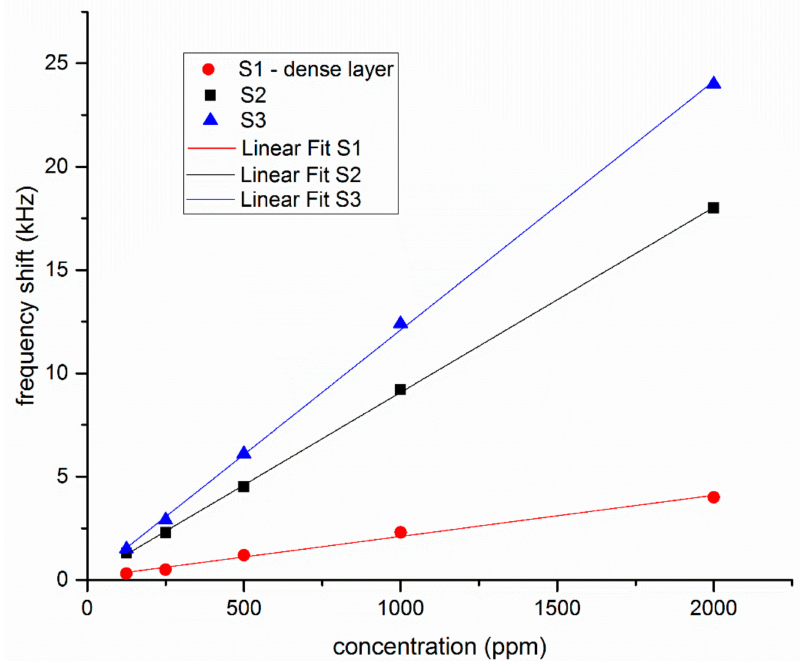
Figure 4. Frequency shifts of sensors S1, S2, and S3, with gold layers deposited in di ff erent conditions as described in text, for various concentrations of chloroform.